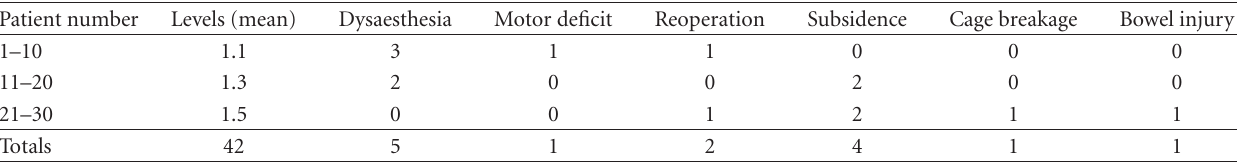
Table 3: Complications and side e ff